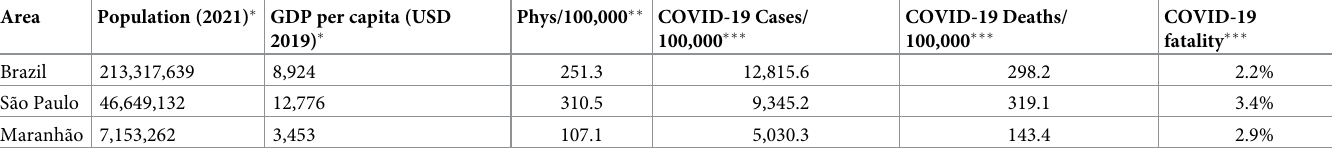
Table 1. Selected economic, health system, and COVID-19 indicators for the study locations at the time of the study.